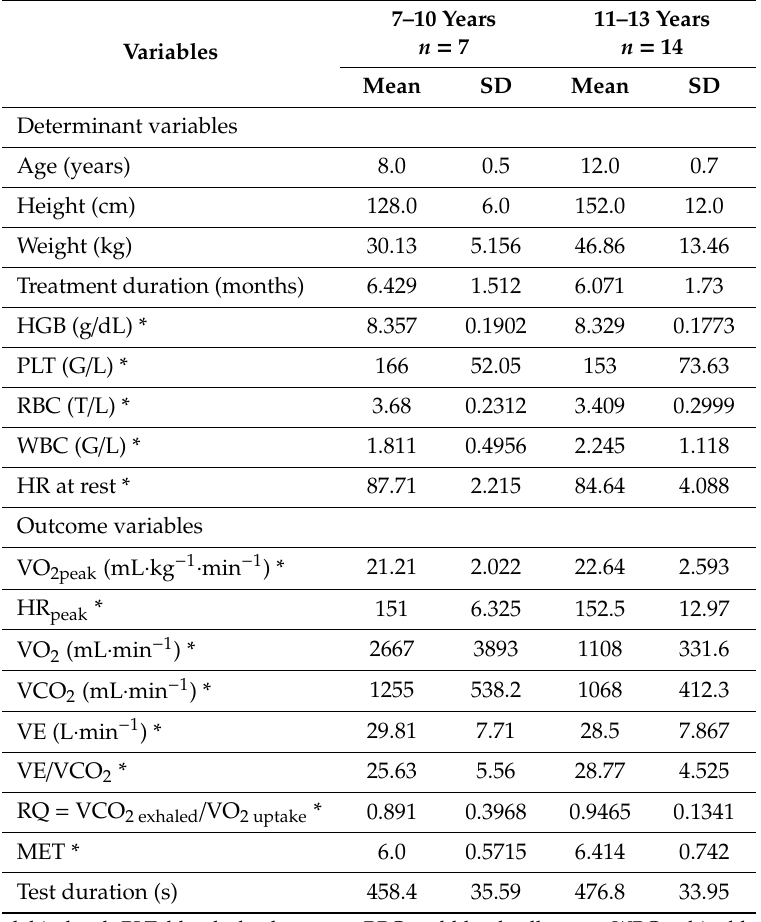
Table 2. Patient characteristics by age group (7–10 and 11–13 years of